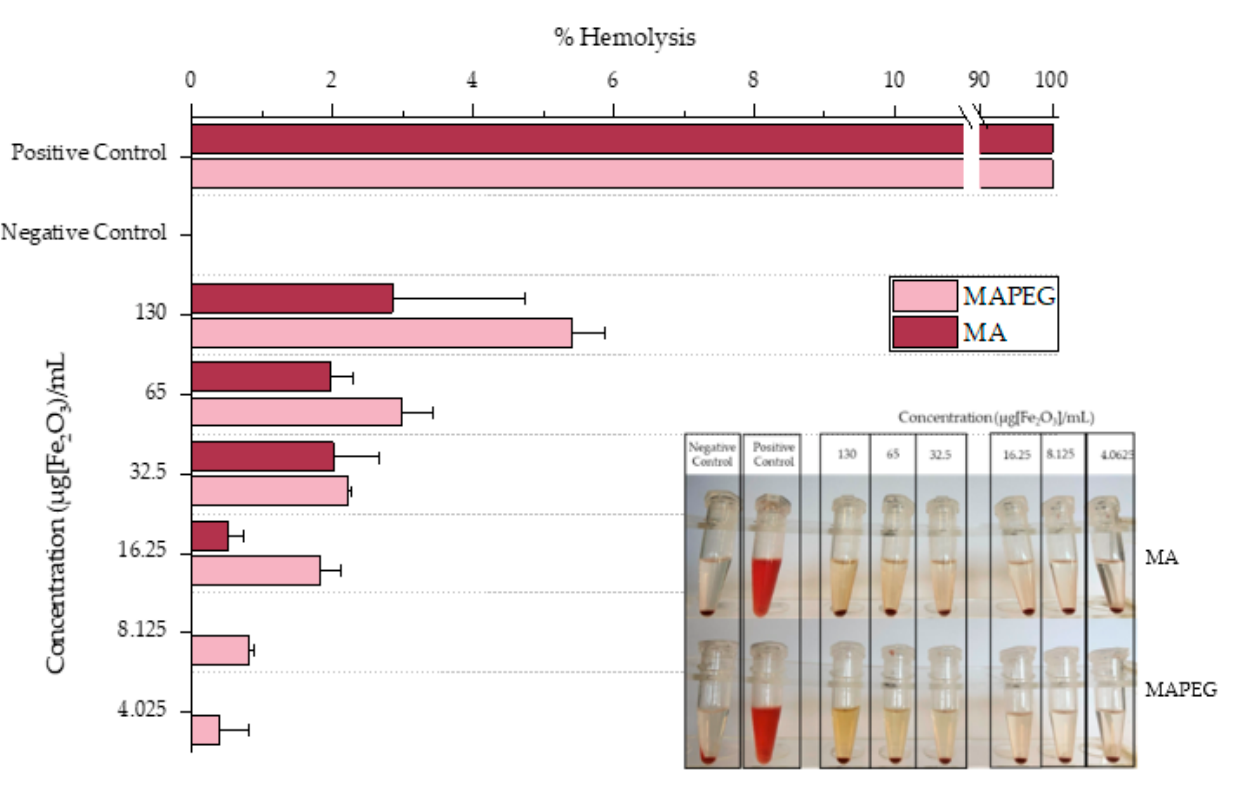
Figure 8. Hemolytic effect of different concentrations of MA and MAPEG. Positive control: 500 μ L H 2 O + 15 μ L of RBCs; negative control: 500 μ L PBS + 15 μ L of RBCs.